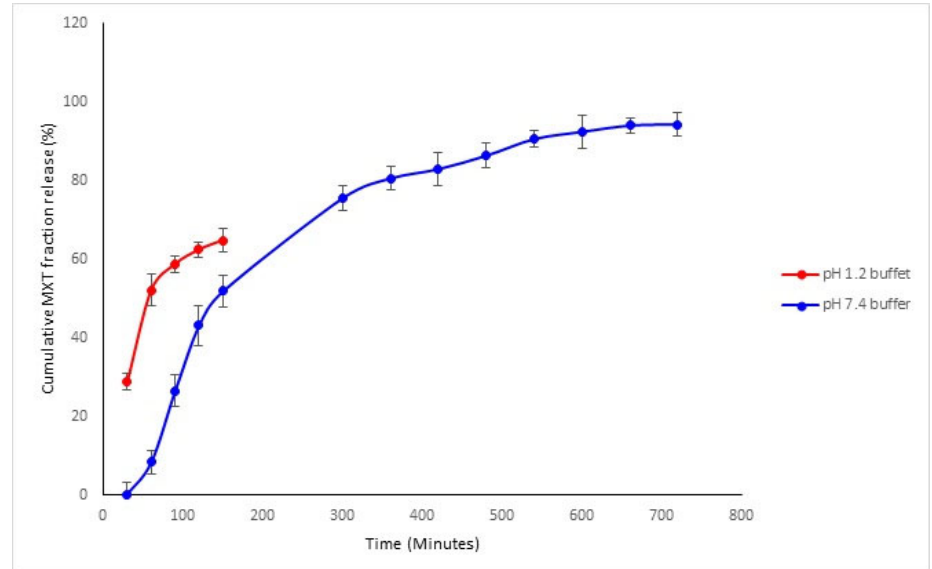
Figure 12. In vitro MTX release from sodium alginate-gelatine nanoparticle formulation conducted in pH 1.2 and pH 7.4 buffer ( n = 3, mean ± SD).